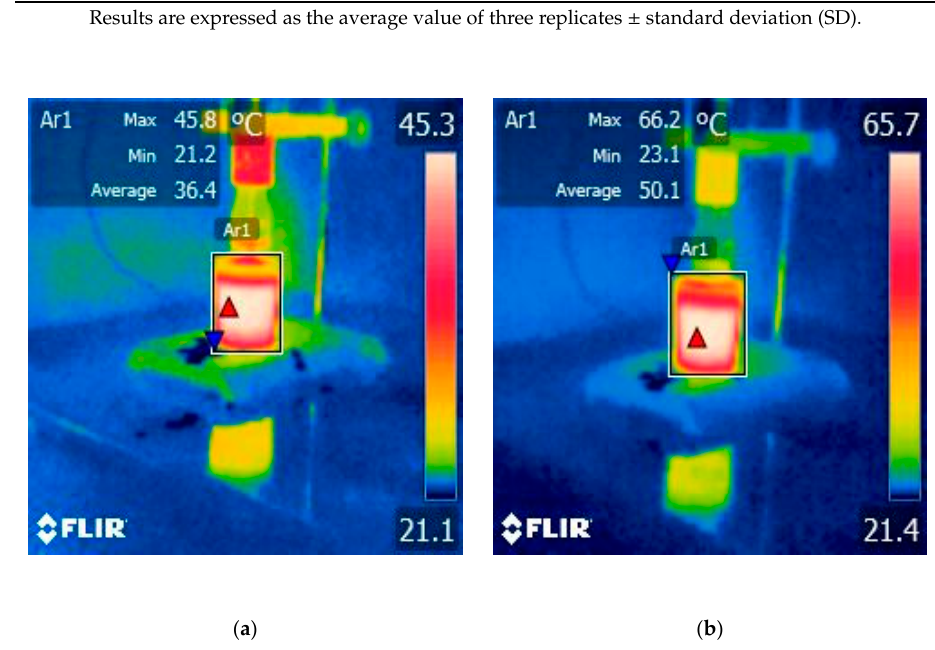
Figure 1. The temperature measured after 5 min of HPU treatment: ( a ) A50%; ( b ) A70%.